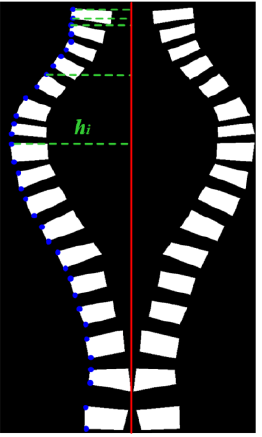
Figure 10. Example of symmetric matching.